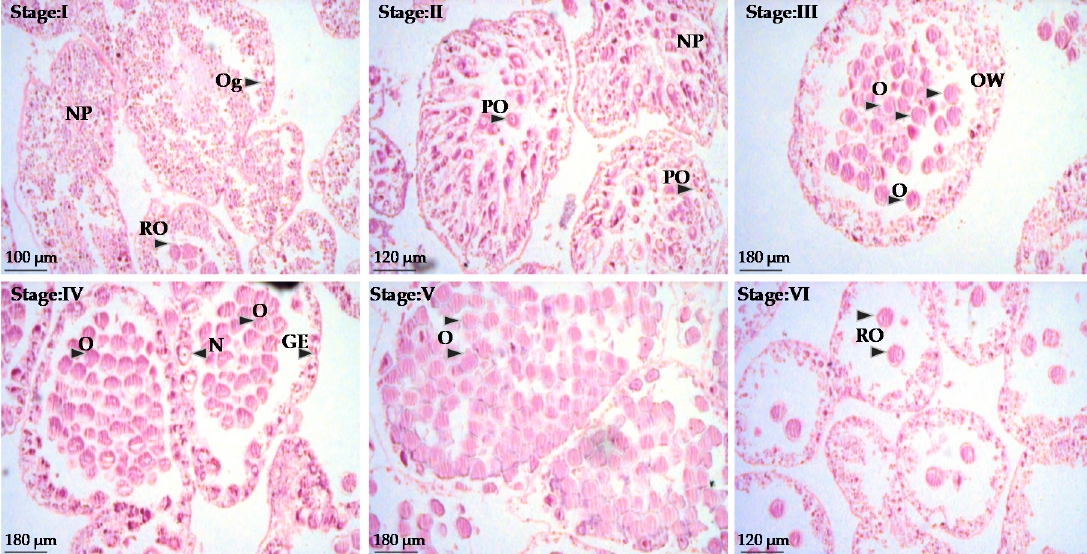
Figure 6. Histology of ovaries of Sphaerechinus granularis . NP = nutritive phagocytes, Og = oogenesis, RO = relict oocytes, PO = previtellogenic oocytes, O = oocytes, OW = ovarian wall, GE = germinal epithelium, N = nucleus, Stage I = recovery, Stage II = growing, Stage III = premature, Stage IV = mature, Stage V = pre-spent, Stage VI = spent.